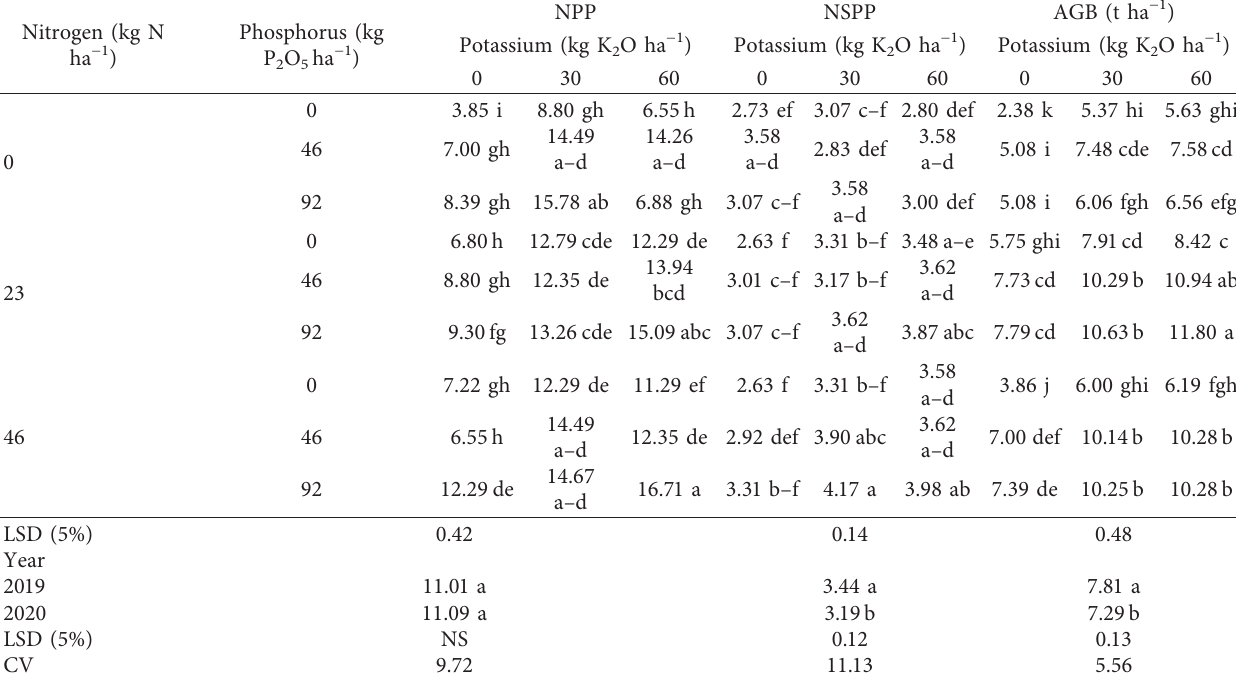
Table 6: Interaction of mineral nitrogen, phosphorus, and potassium fertilizers and the main effects of the growing year on the yield components and yield of faba bean.